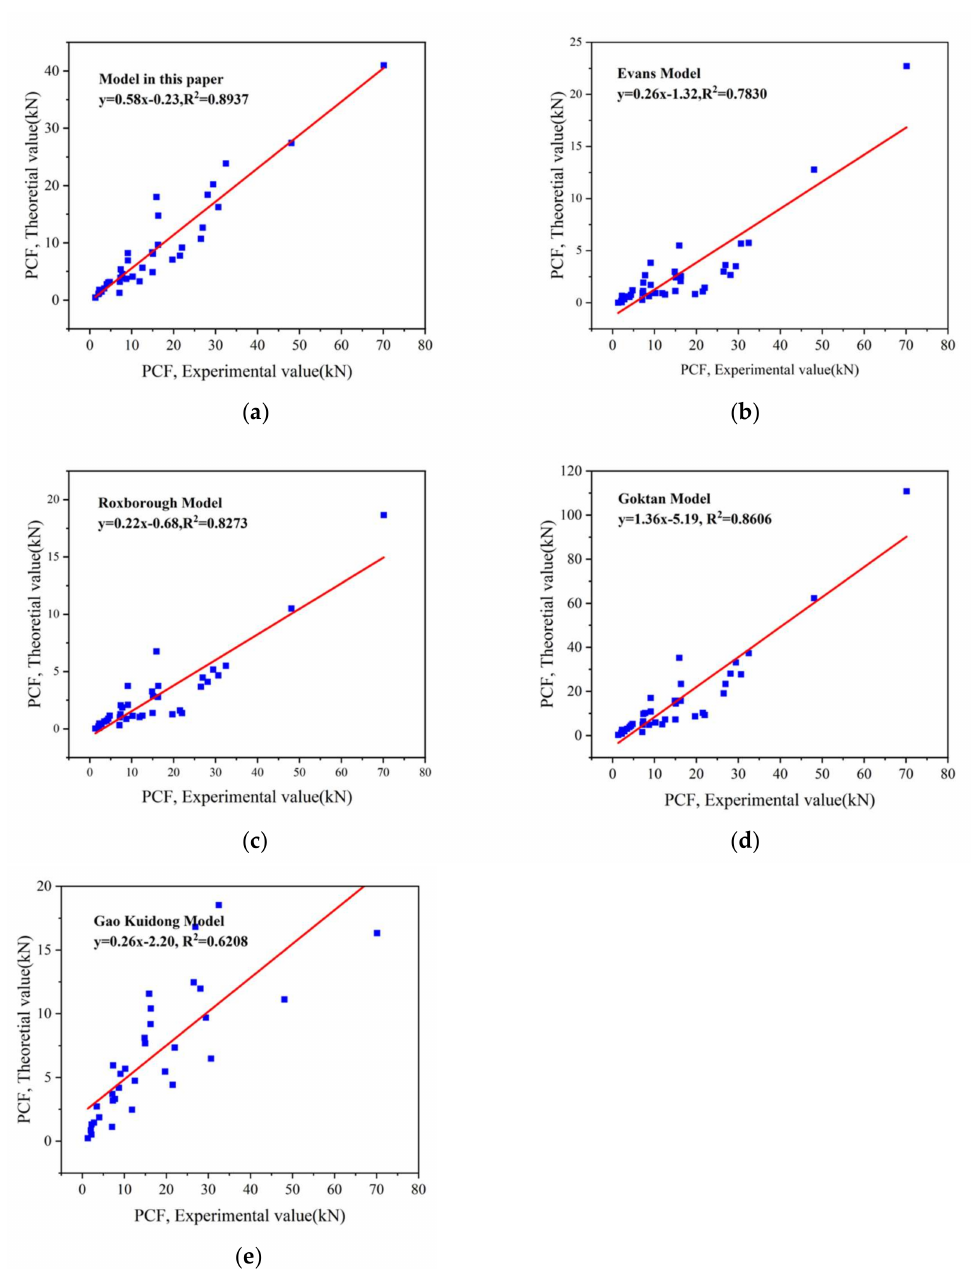
Figure 6. The relationship between theoretical model calculation results and experimental results for the 1st prediction performance analysis. ( a ) Theoretical model of peak cutting force in this paper; ( b ) Evans model; ( c ) Roxborough model; ( d ) Goktan Semi-empirical model; ( e ) Gao Kuidong model. The peak cut-off force data of 27 rock samples under 61 cutting conditions are analyzed by linear regression, and the fitted lines of the theoretical results and test results of the five models are obtained as shown in Figure 7. When the number of rock samples increased from 18 to 27, the coefficients determination R 2 of the five models showed a significant decrease. When the coefficient of determination R 2 is greater than 0.8, which indicates a strong correlation between the two variables, and when R 2 is less than 0.3, it is considered that there is no correlation between the two variables, otherwise it is considered to have a weak correlation. Figure 7 shows that only the model in this paper has a relatively strong correlation of 0.7792, which is close to 0.8, while the R 2 of the other four models have a relatively large gap to